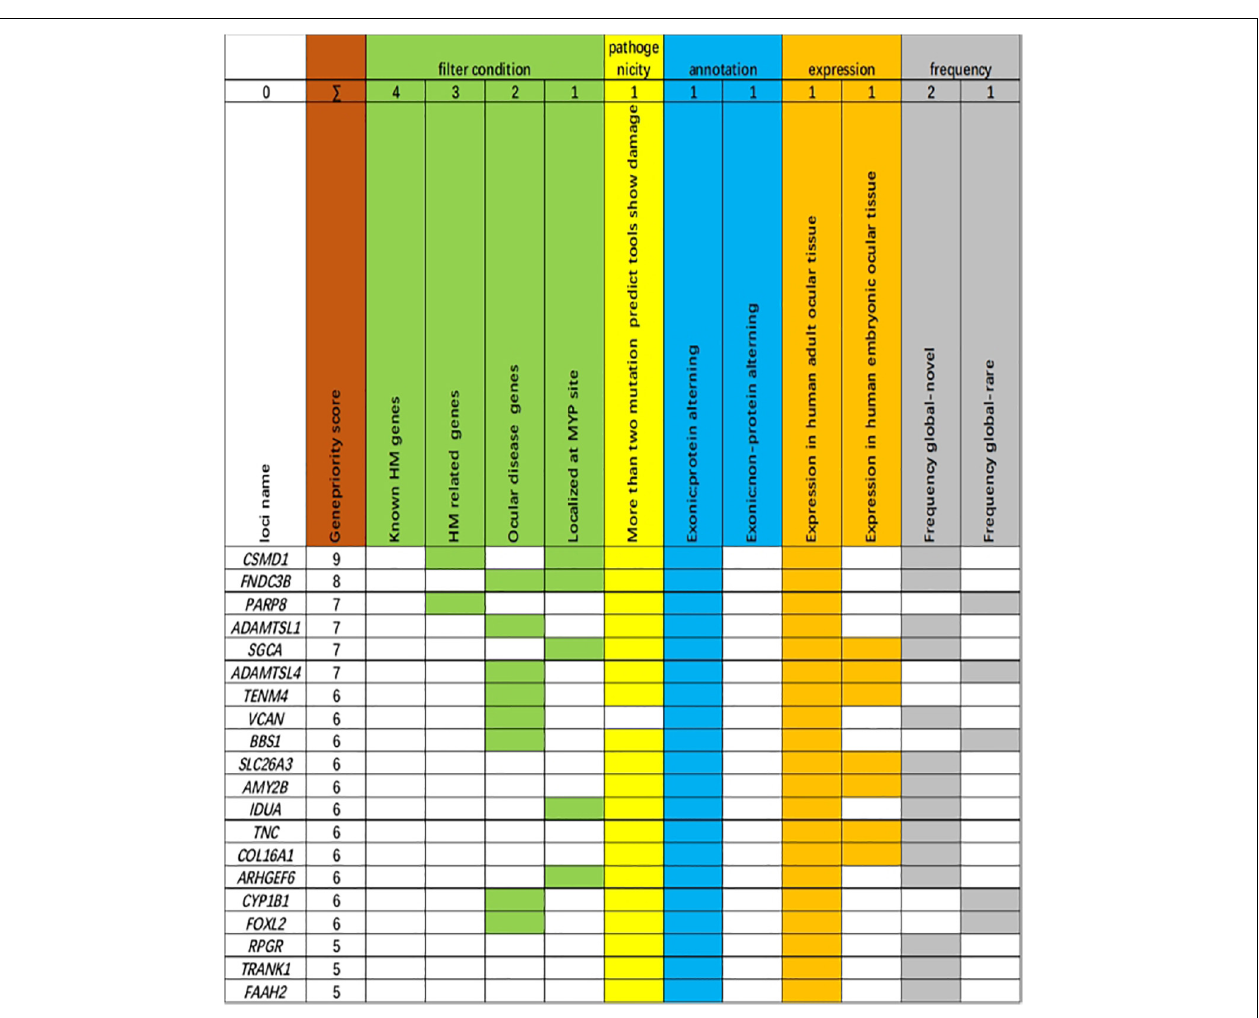
FIGURE 3 | Genes ranked according to biological and statistical evidence. Genes were ranked based on 11 categories that can be divided into five categories: filter condition [green: genes are related to known high myopia (HM) genes, HM-related genes, ocular disease genes, or localized at the MYP site], pathogenicity (light yellow: more than two mutation predict tools show damage), annotation (light blue: genetic variant harboring an exonic protein altering variant or non-protein-altering variant), expression (dark yellow: expression in adult human ocular tissue, expression in human embryonic ocular tissue), and frequency [light dark: frequency global in Exome Aggregation Consortium (ExAC) database, novel; frequency global in ExAC database,